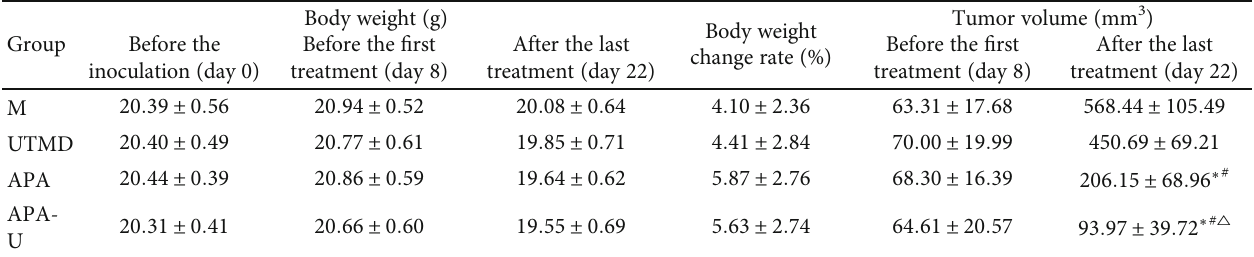
Table 1: Body weight and tumor volume before and after treatments in di ff erent groups ( n = 10 , (cid:1) x ± SD ). Body weight (g) Group